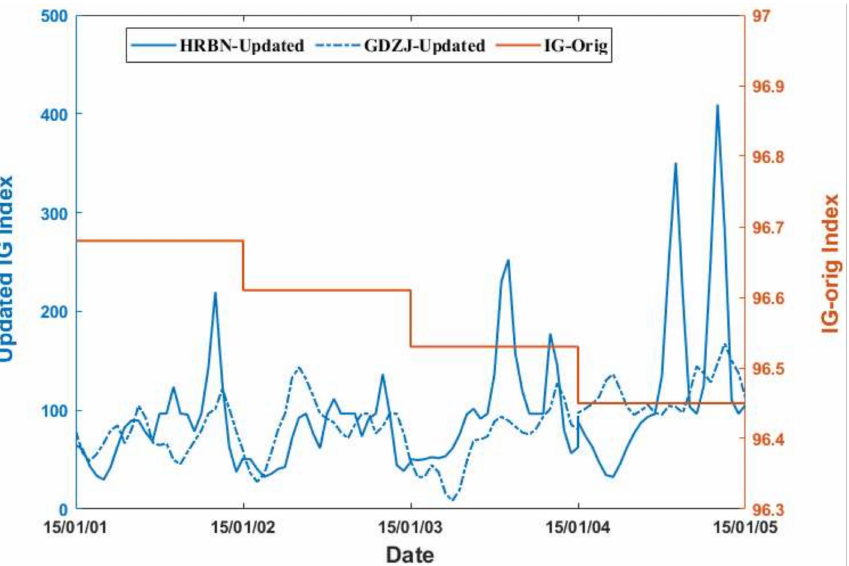
Figure 2. Updated IG 12 index (IG-up) at stations HRBN and GDZJ (HRBN-Updated and GDZJ- Updated) and the original IG 12 index